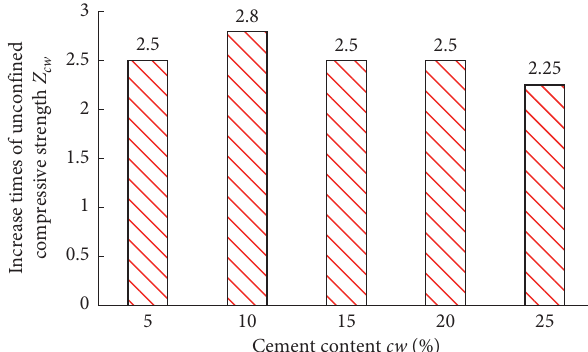
Figure 8: Multiple changes in the strength of CMS with different cement contents during the curing